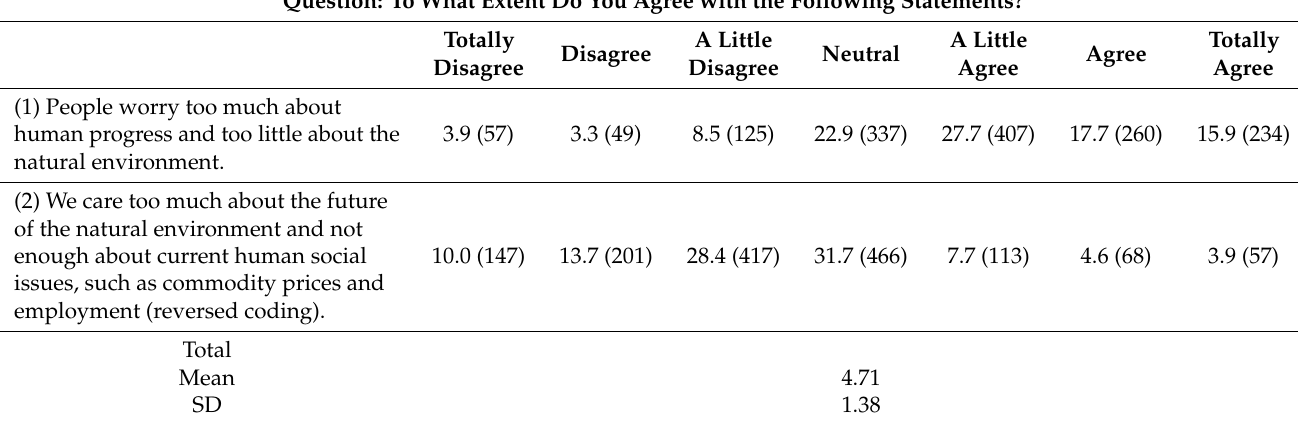
Table 7. Participants’ environmental value ( n =